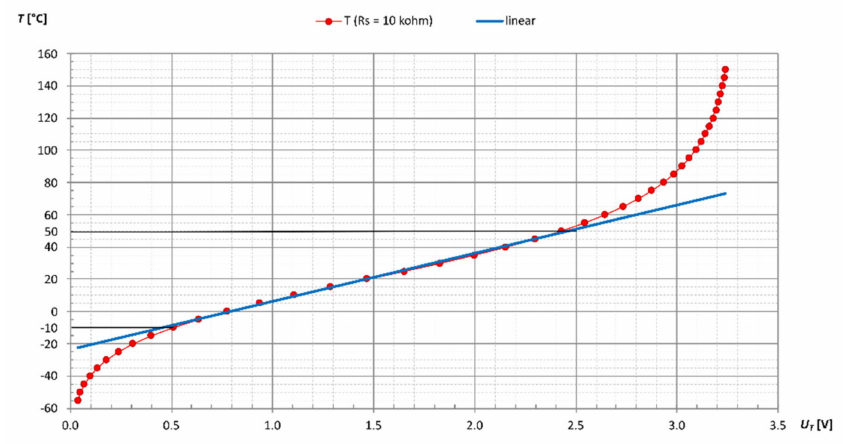
Figure 8. Temperature vs. calculated voltage for manufacturer-based data and linear approximation.